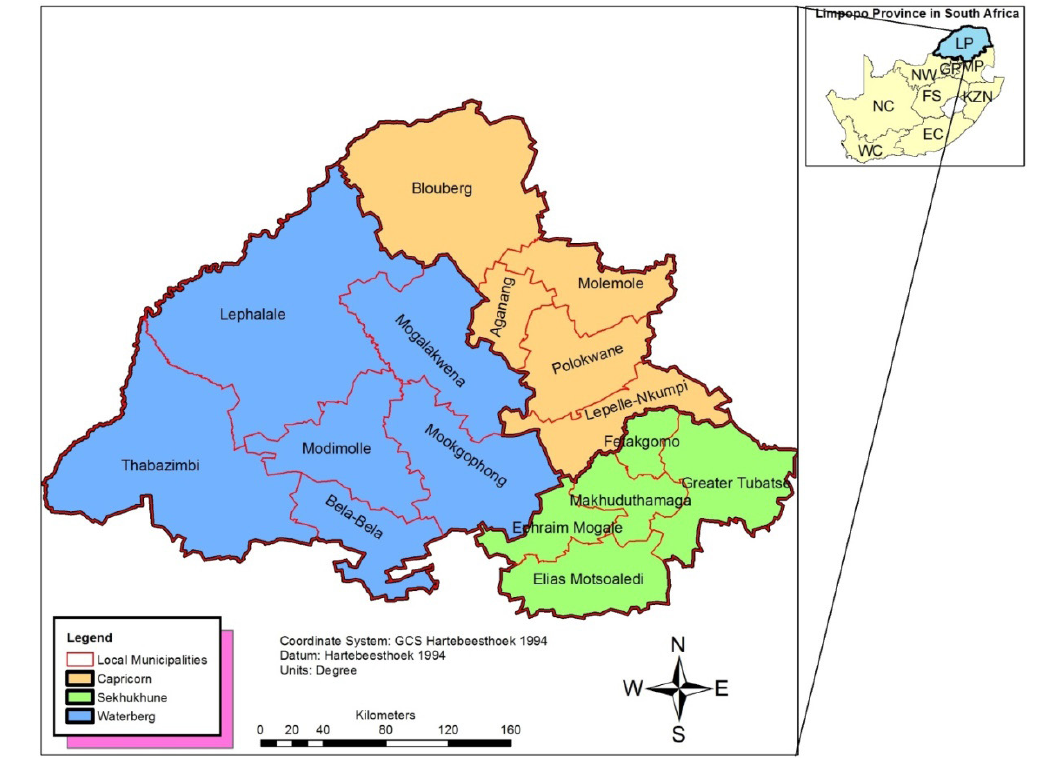
Fig. 1: Map of Limpopo Province indicating the studied areas (districts and